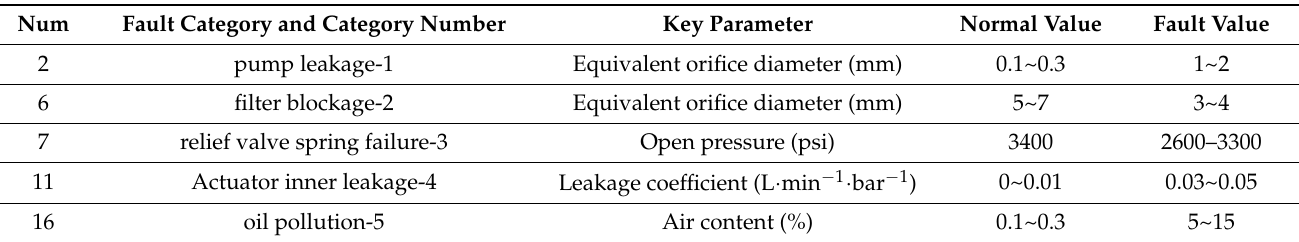
Table 2. Fault state values of the hydraulic